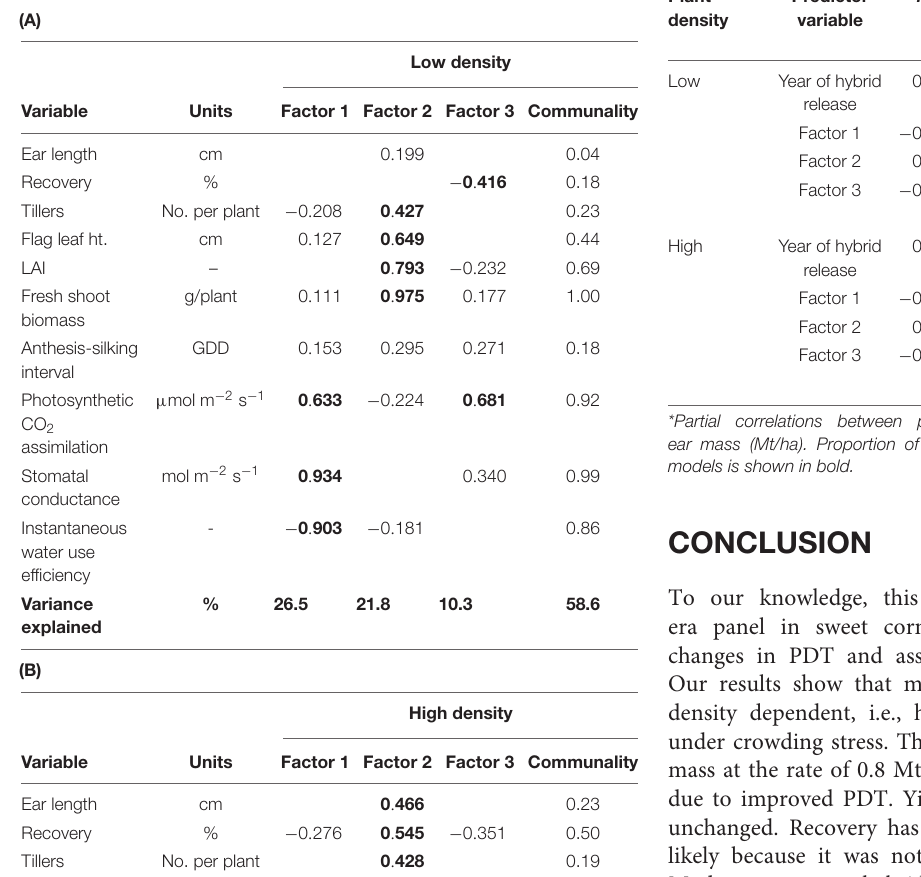
TABLE 3 | Exploratory factor analysis results, based on varimax rotation, using the correlation matrix of select ear, growth and development, and leaf gas exchange traits measured at (A) Low and (B) High plant densities across all sweet corn hybrids at Urbana, IL in 2018–2020.